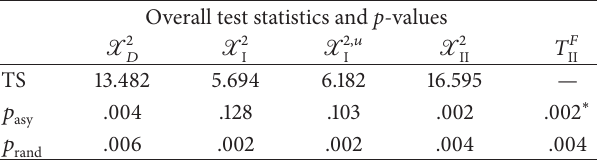
Table15:Theteststatisticsandthe p -valuesfortheoverallsymmetry analysis for the Lansing Woods data. TS stands for the test statistic, 𝑝 for the p -values based on asymptotic critical values (except asy for the p -values based on Monte for the exact tests), and 𝑝 rand Carlo randomization. ∗ The p -values for the exact tests are not the asymptotic p -values but computed as described in Section 3.